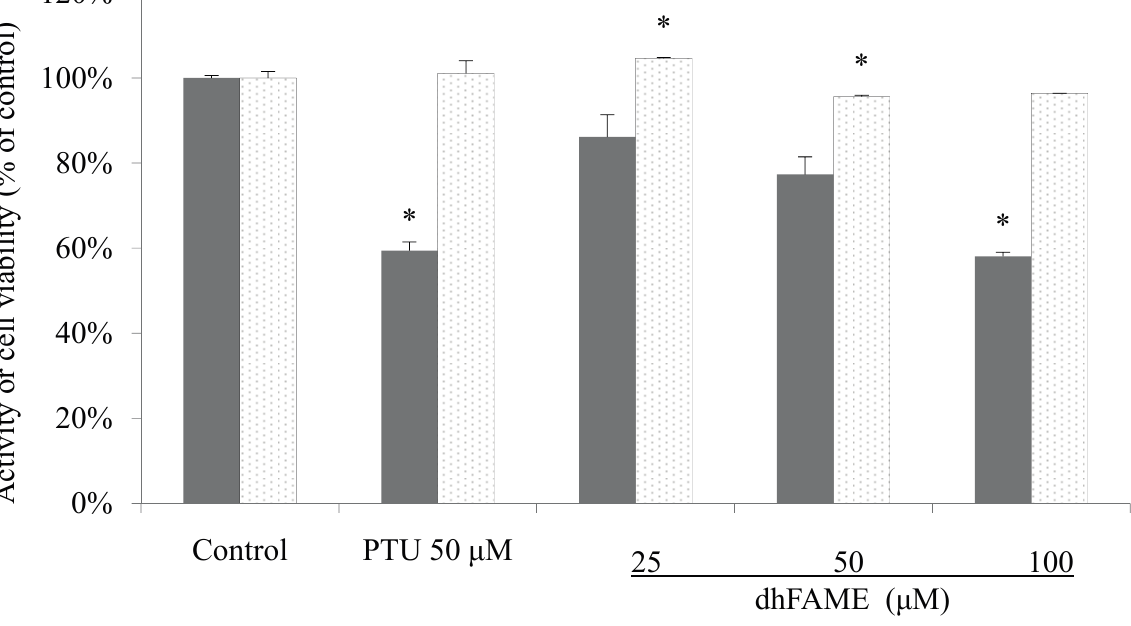
Figure 3. Effect of dhFAME on melanogenesis and cell viability in Melan-a cells. Cells (1 × 10 5 cells/mL) were cultured for 24 h, and the medium was replaced with fresh medium containing various concentrations of compound and PTU (phenylthiourea) for 3